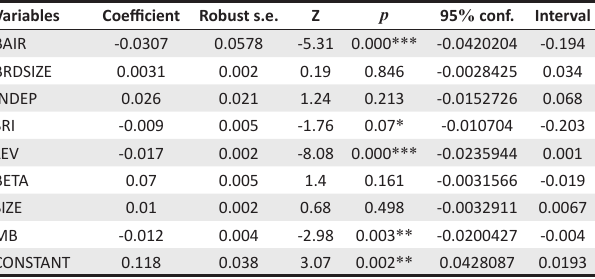
TABLE 6: Regression results: Cost of equity (before and after integrated reporting framework).